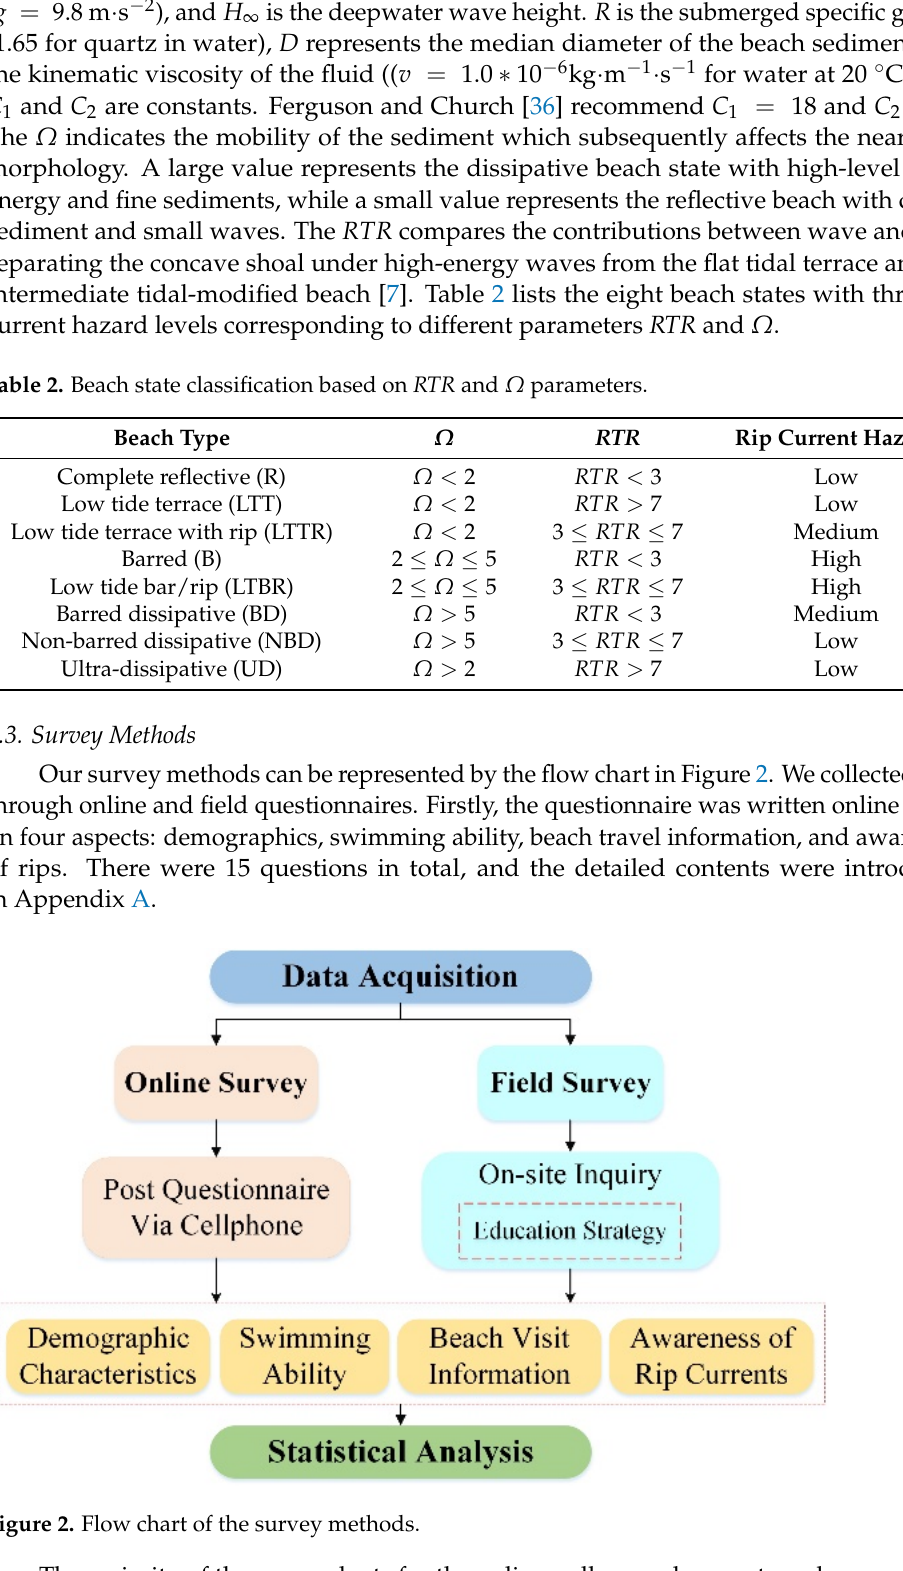
Table 2. Beach state classification based on RTR and Ω parameters.